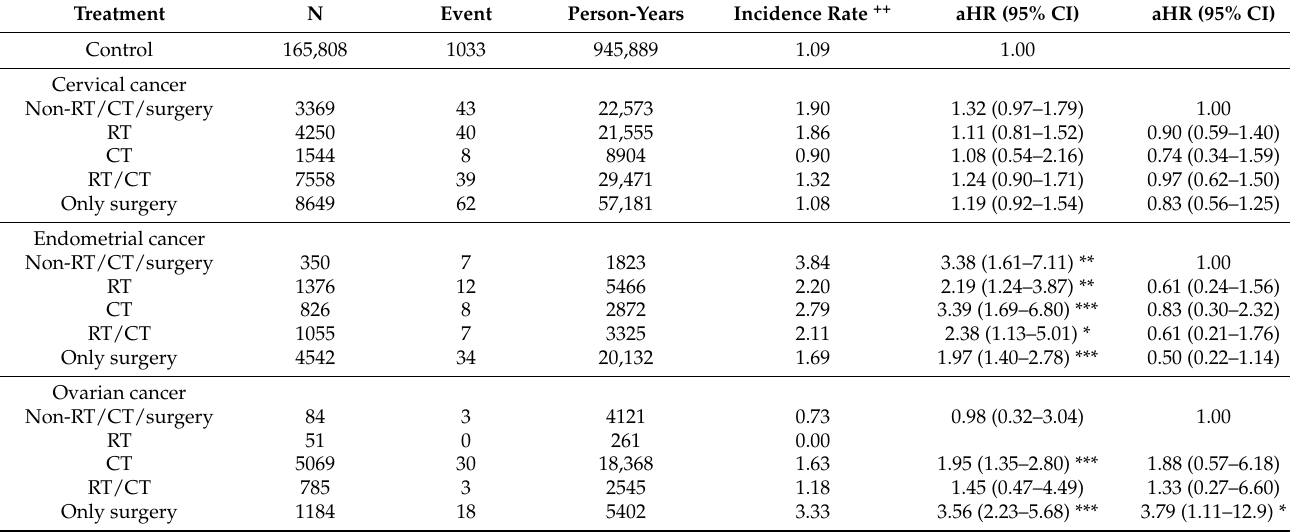
Table 3. Incidence and adjusted hazard ratio of colorectal cancer by type of treatment for patients with gynecologic cancers and reference